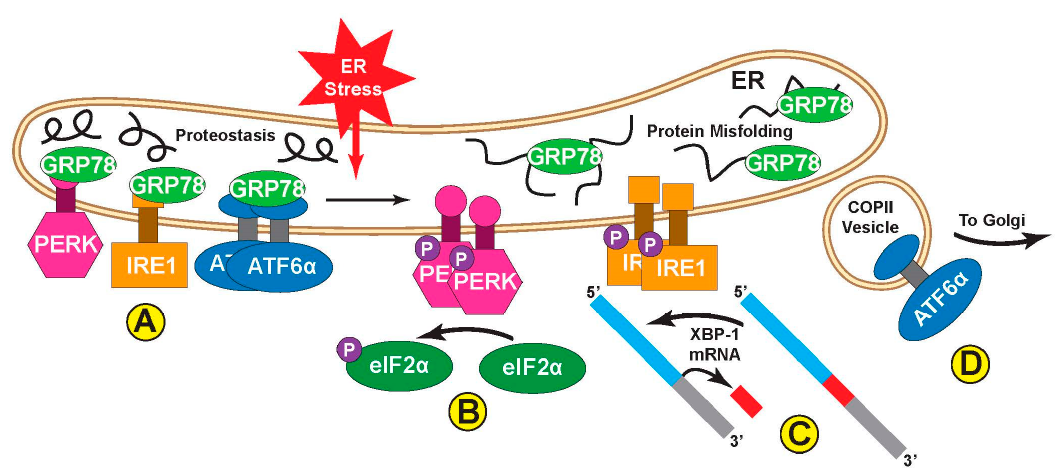
Figure 1. Overview of the activation of the three branches of the ER UPR. ( A ) PERK, IRE1, and ATF6 α are all ER transmembrane proteins with cytosolic and luminal domains that act as sensors to detect the build-up of misfolded proteins characteristic of ER stress. When the capacity of the ER to